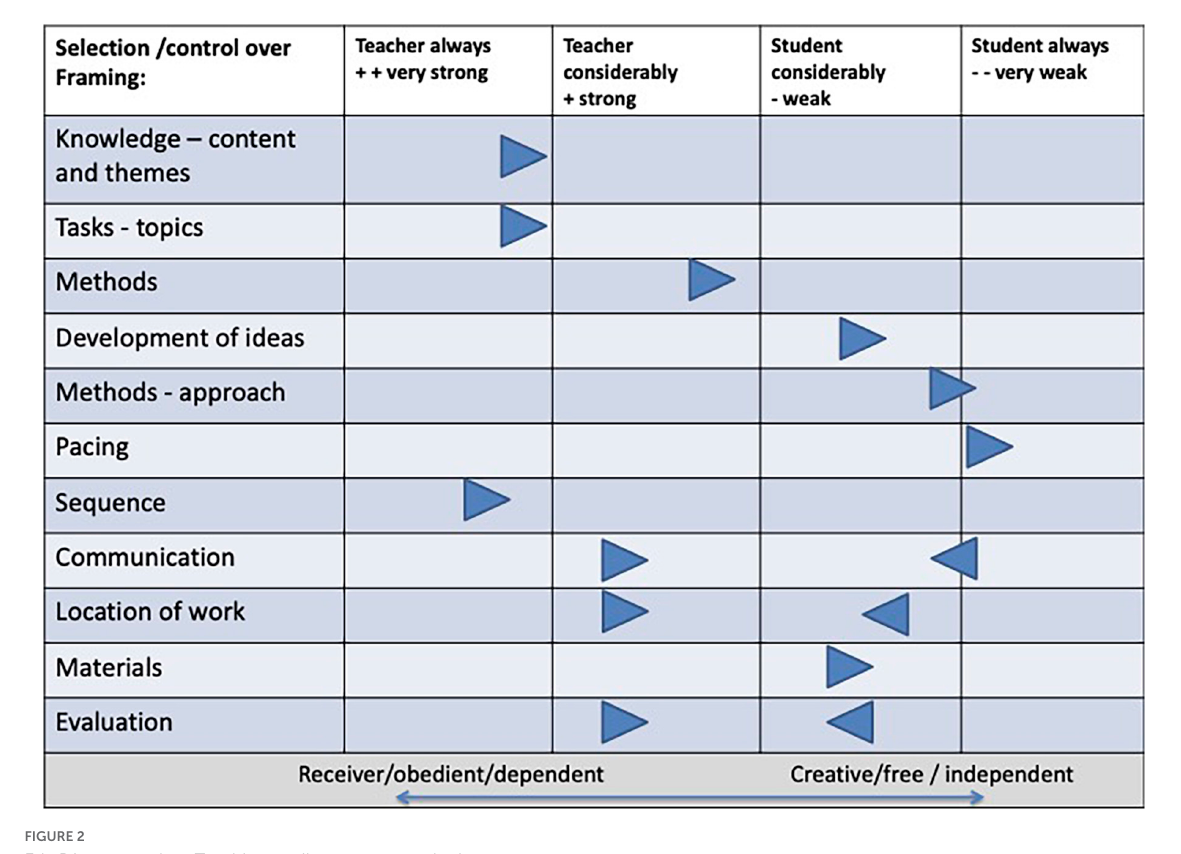
FIGURE2 Erla Dís – example – Teaching textiles: patterns and